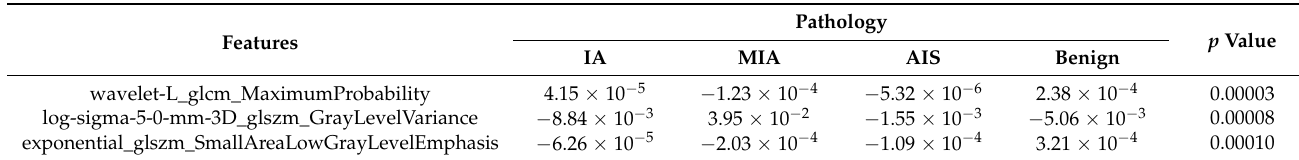
Table 6. The first three follow-up features with the lowest p